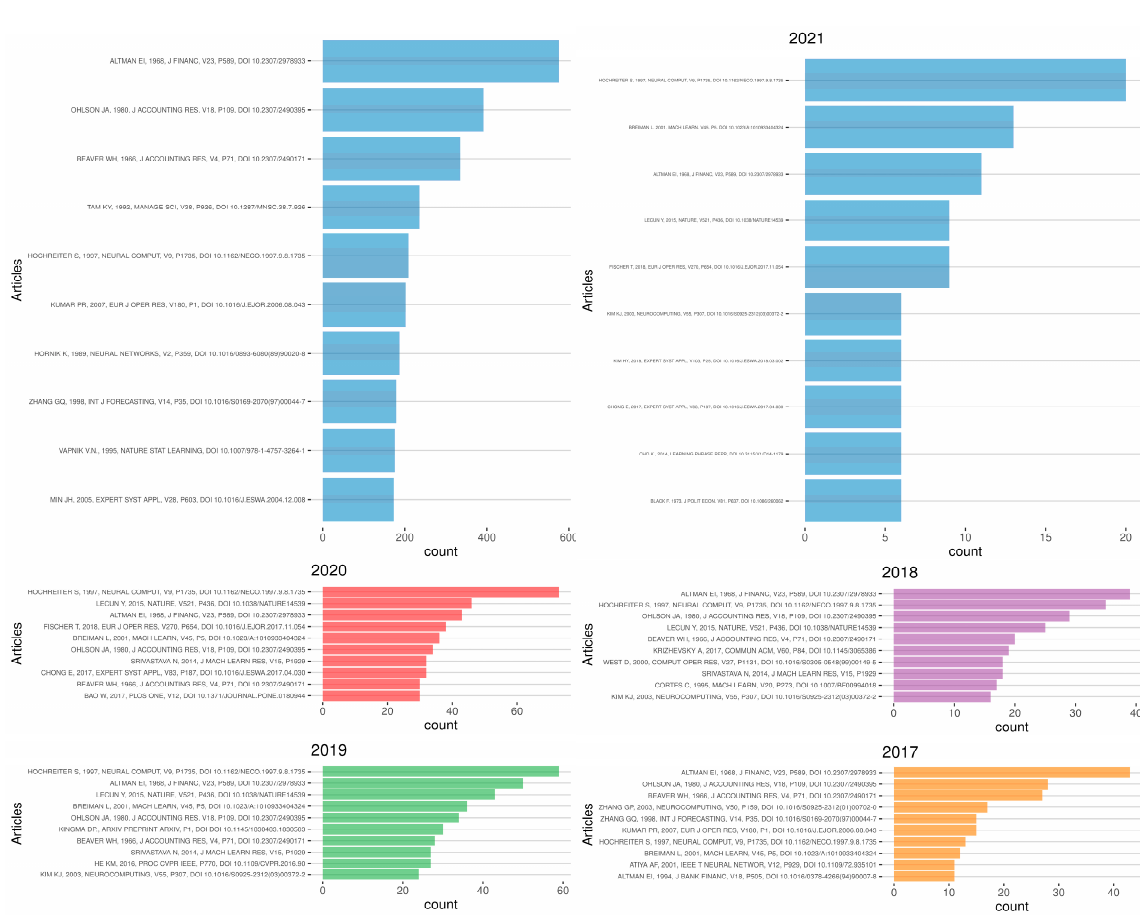
Figure 9. Most cited manuscripts, overall period, and per year.